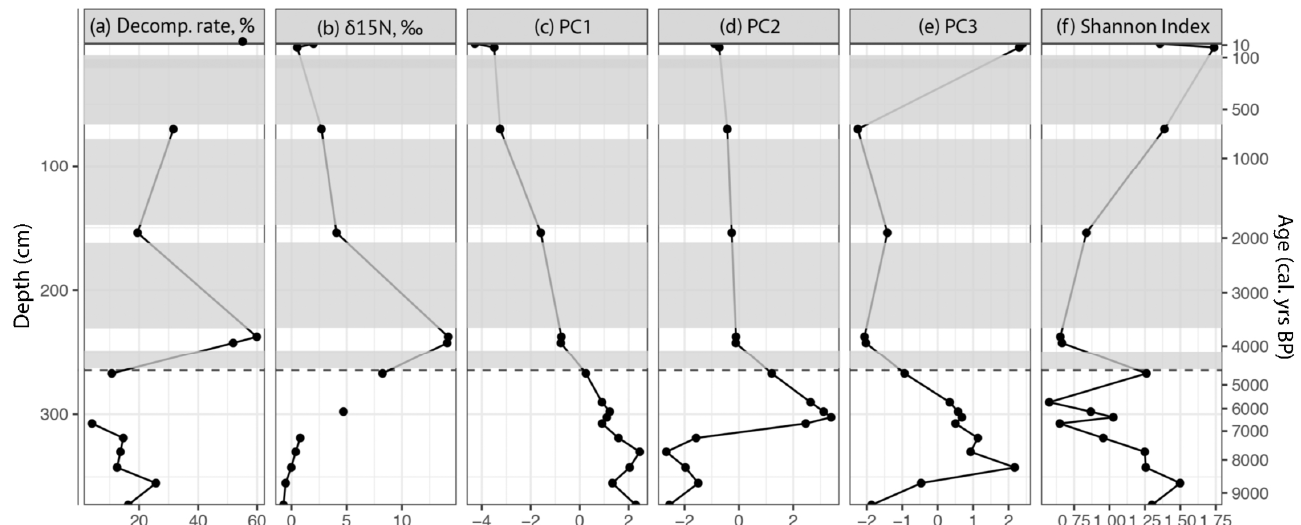
Figure 3. Dynamics of environmental conditions: decomposition rate ( a ), δ N 15 ( b ), and diatom community parameters: first three principal components ( c – e ) and Shannon Index ( f ). PC1 is associated with cold-water and terrestrial diatoms, PC2 with benthic and epiphytic diatoms, and PC3 with taxa inhabiting moist soil and mosses (see Tables 1 and 2). Dashed line marks the border between Zone 1 and Zone 2 (at 265 cm), while areas of gray color mark layers of sandy content with no diatom valves found.